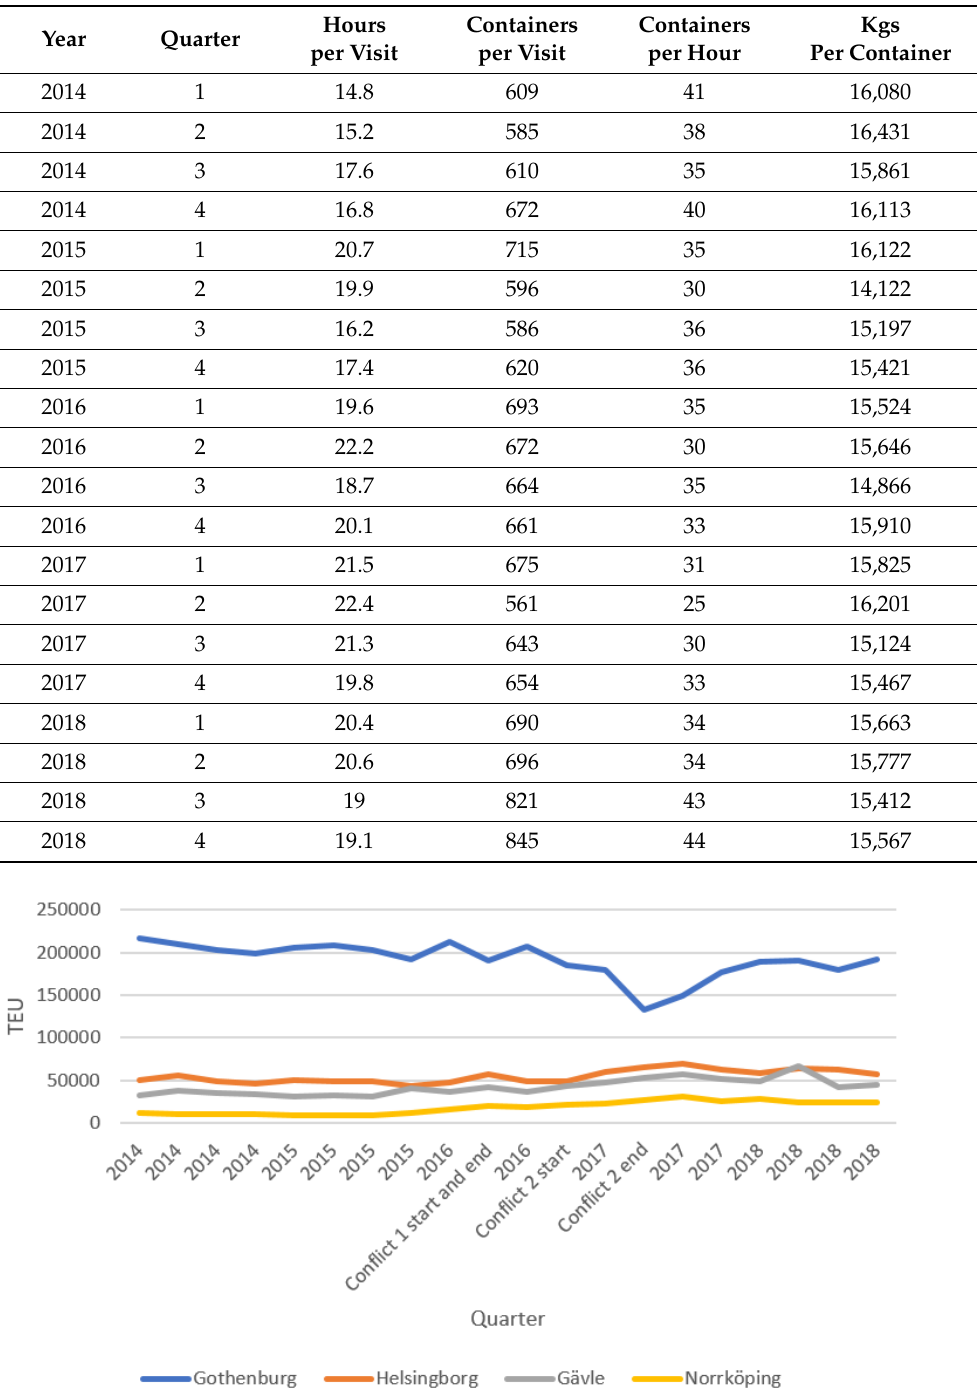
Table 3. Calculated Performance Indicators for the Port of Gothenburg.